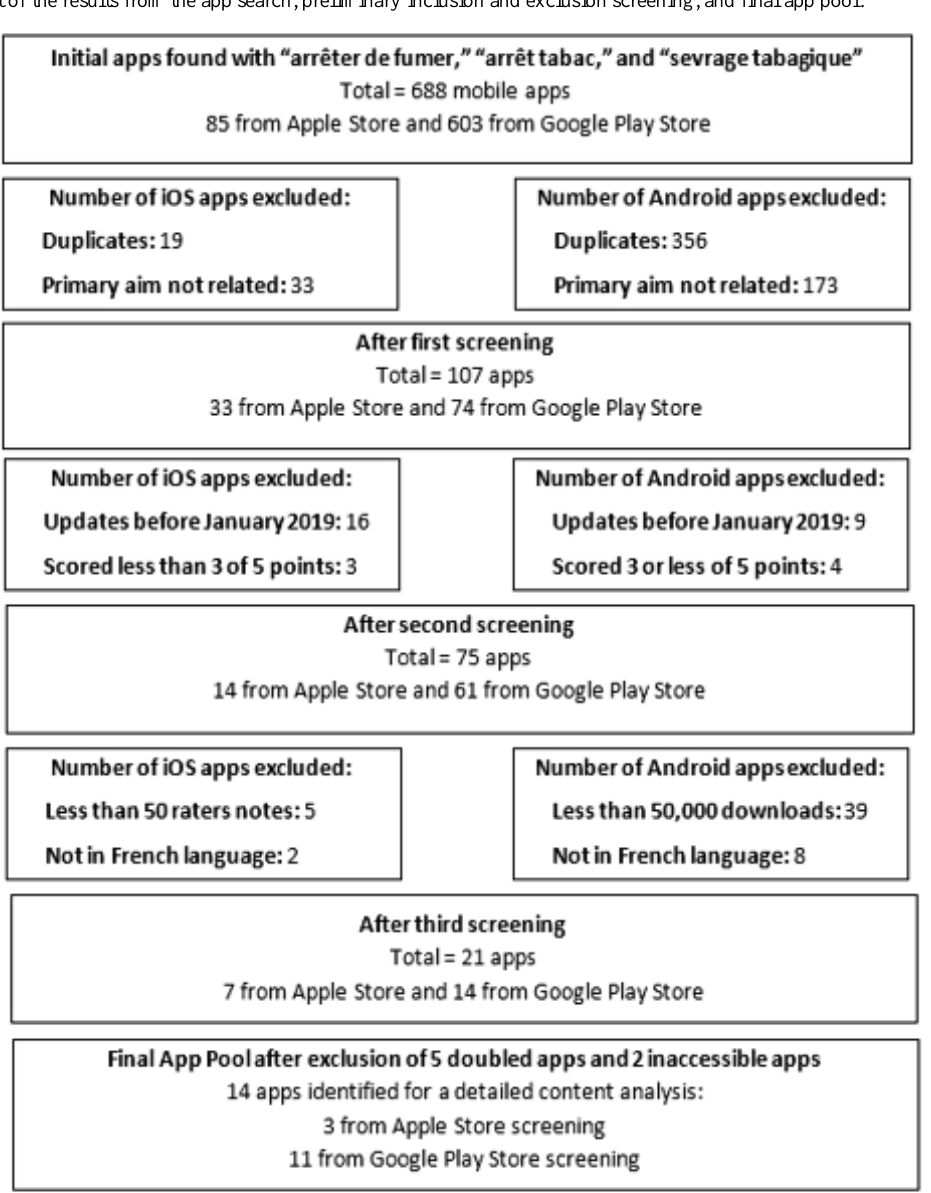
Figure 1. Flowchart of the results from the app search, preliminary inclusion and exclusion screening, and final app